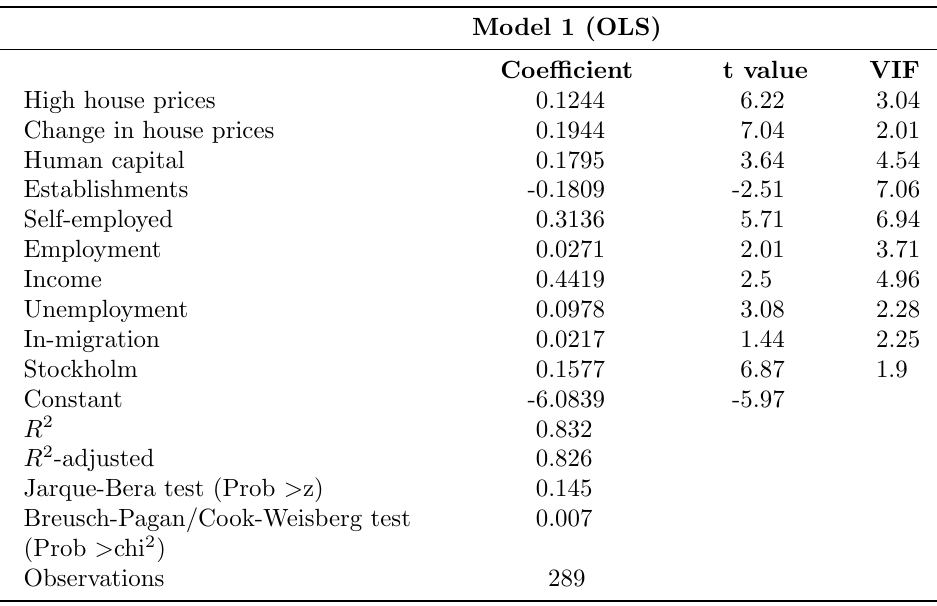
Table 3: Regression analysis (OLS-results)